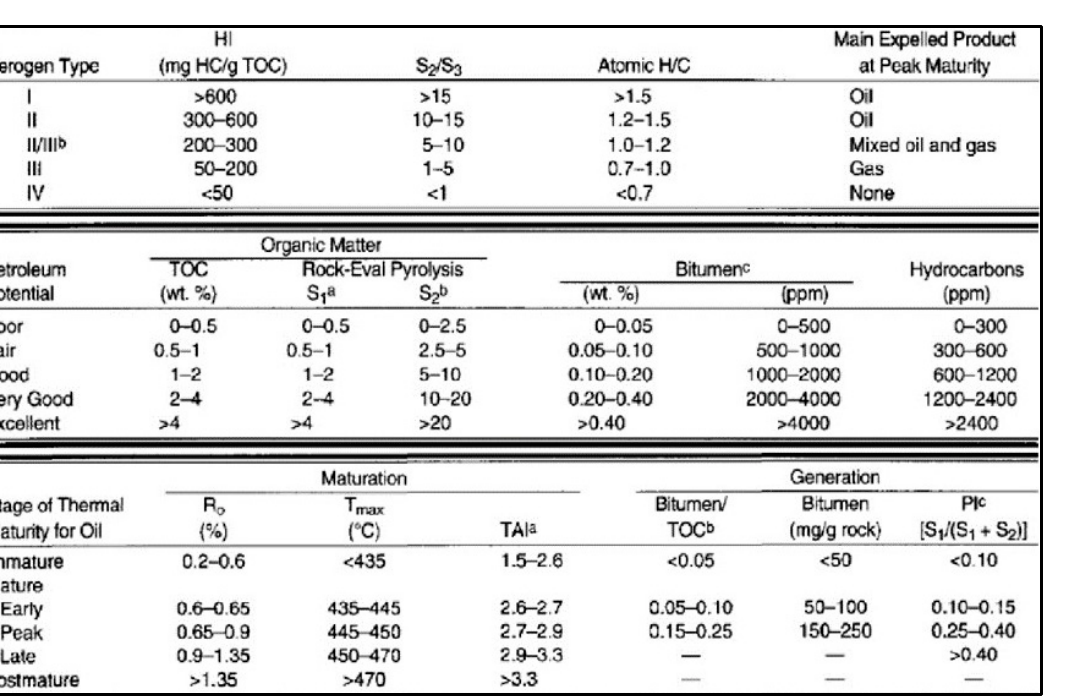
Table 3. The ratio of